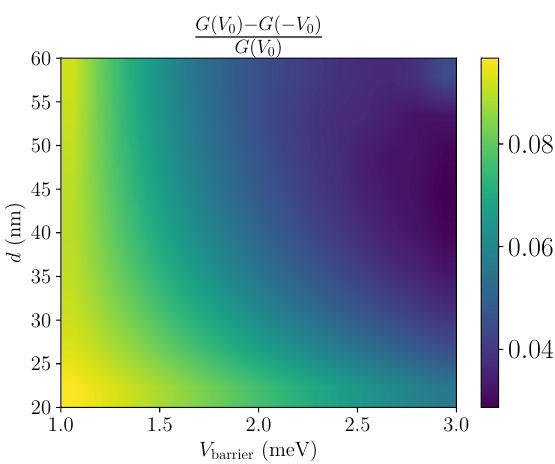
Figure 6: Normalized height asymmetry of conductance peaks in proximitized = 0 for varying barrier width d and height nanowire with ∆ = 0.25 meV and V Z V . The asymmetry vanishes as either the system is tuned deeper into the tun- barrier neling